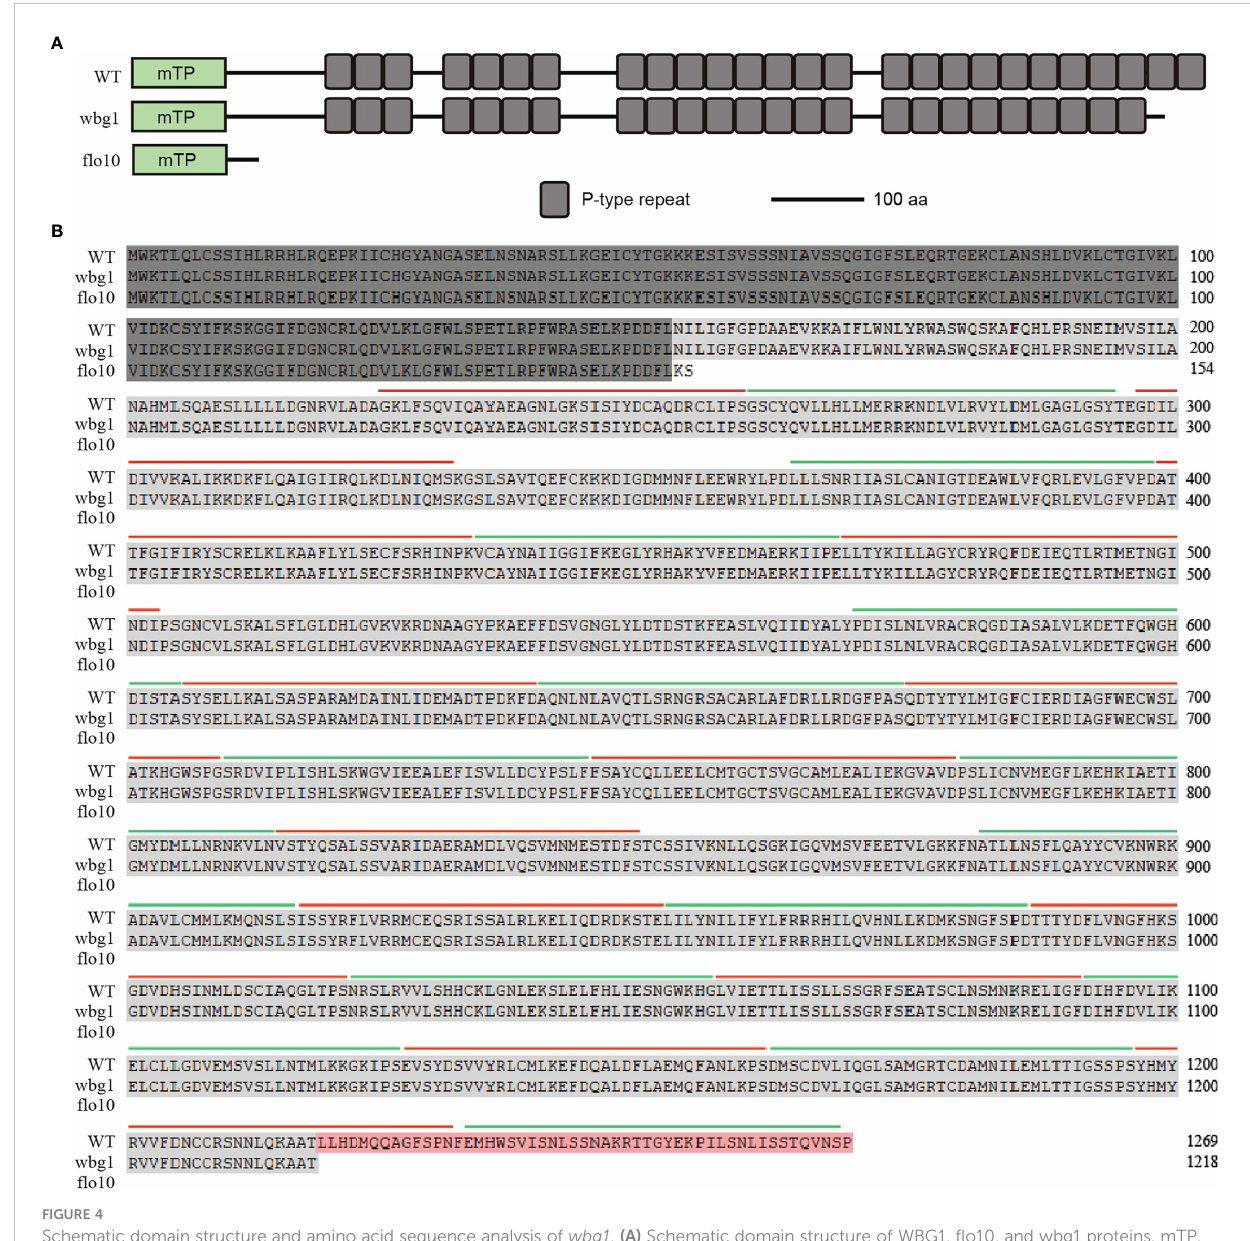
FIGURE 4 Schematic domain structure and amino acid sequence analysis of wbg1 . (A) Schematic domain structure of WBG1, fl o10, and wbg1 proteins. mTP, mitochondrion target peptide predicted by TargetP. WBG1/FLO10 comprises 1,269 amino acids with 26 predicted PPR repeats; the fl o10 mutant lost all PPR motifs, while wbg1 only lost the last two PPR motifs at the C-terminal. (B) Sequences alignment of WBG1, wbg1, and fl o10 proteins with predicted PPR repeat annotations. Amino acid residues present in all three sequences are indicated by dark gray shading. Light gray shading indicates the residual amino acids present in wbg1 and WBG1. The amino acid sequence at the C-terminal that is deleted in wbg1 but present in WBG1 is shaded orange. Each PPR repeat is indicated alternately by green and red